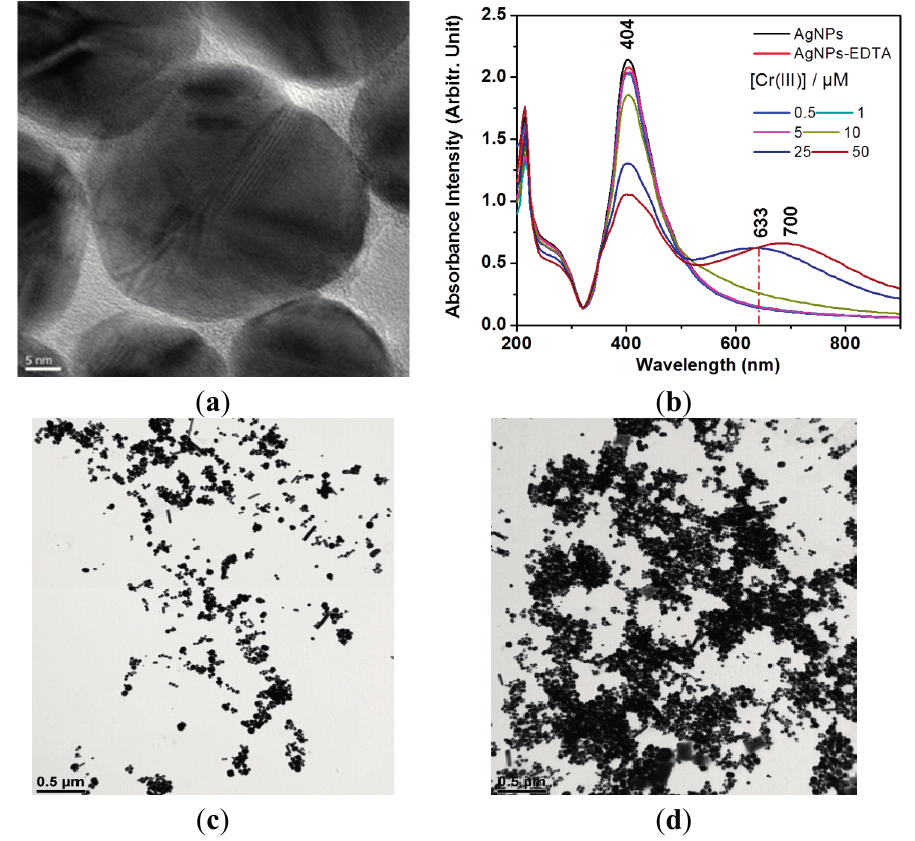
Figure 2. ( a ) TEM image of silver nanoparticles (AgNPs). The scale bar indicates 5 nm; ( b ) UV-Vis absorption of AgNPs upon binding of EDTA with Cr(III). TEM images of aggregated AgNPs with EDTA at [Cr 3+ ] of ( c ) 0 and ( d ) 50 μ M. The scale bars indicate 0.5 μ